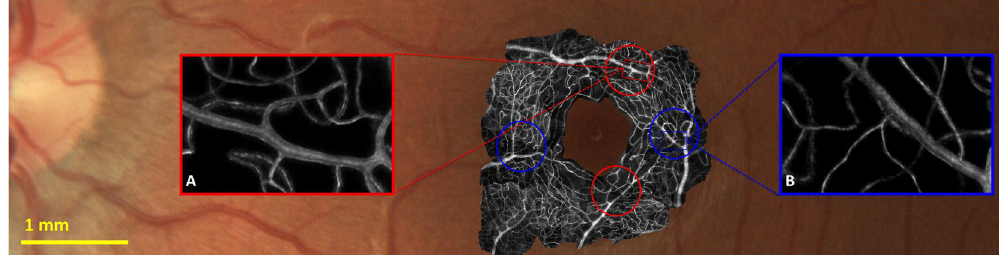
Figure 6. Standard retinal image showing inner retinal vasculature of one participant (color photo) overlaid with motion contrast adaptive optics images (black and white) demonstrating the size and location of vessels analysed in this study. Inset outlined in red ( A ) shows an example region of interest containing a “major” arteriole; inset outlined in blue ( B ) shows an example region of interest containing a “major” venule. Both correspond to the regions of interest illustrated in Fig.